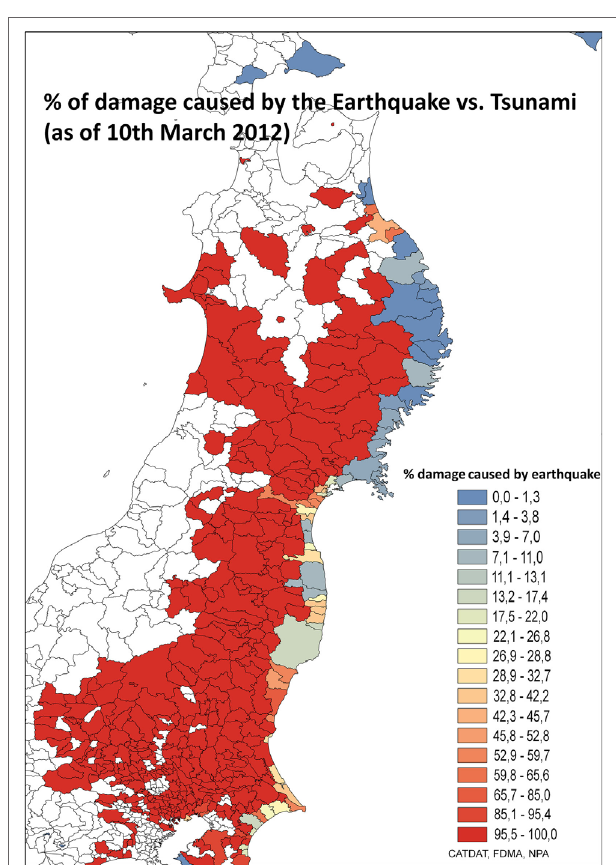
FigUre 8 | The disaggregated earthquake versus tsunami damage in each municipality (dark red = 100% damage caused by earthquake, dark blue = 100% damage caused by tsunami, and yellow = 50% damage via earthquake, 50% via tsunami) .